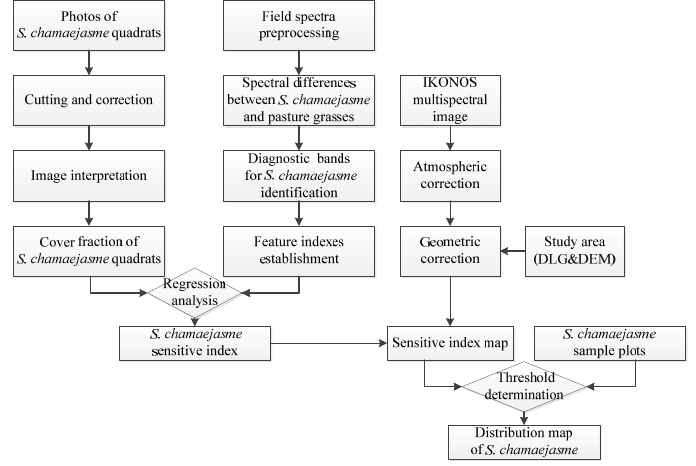
Figure 2. Flow chart of the methodology.